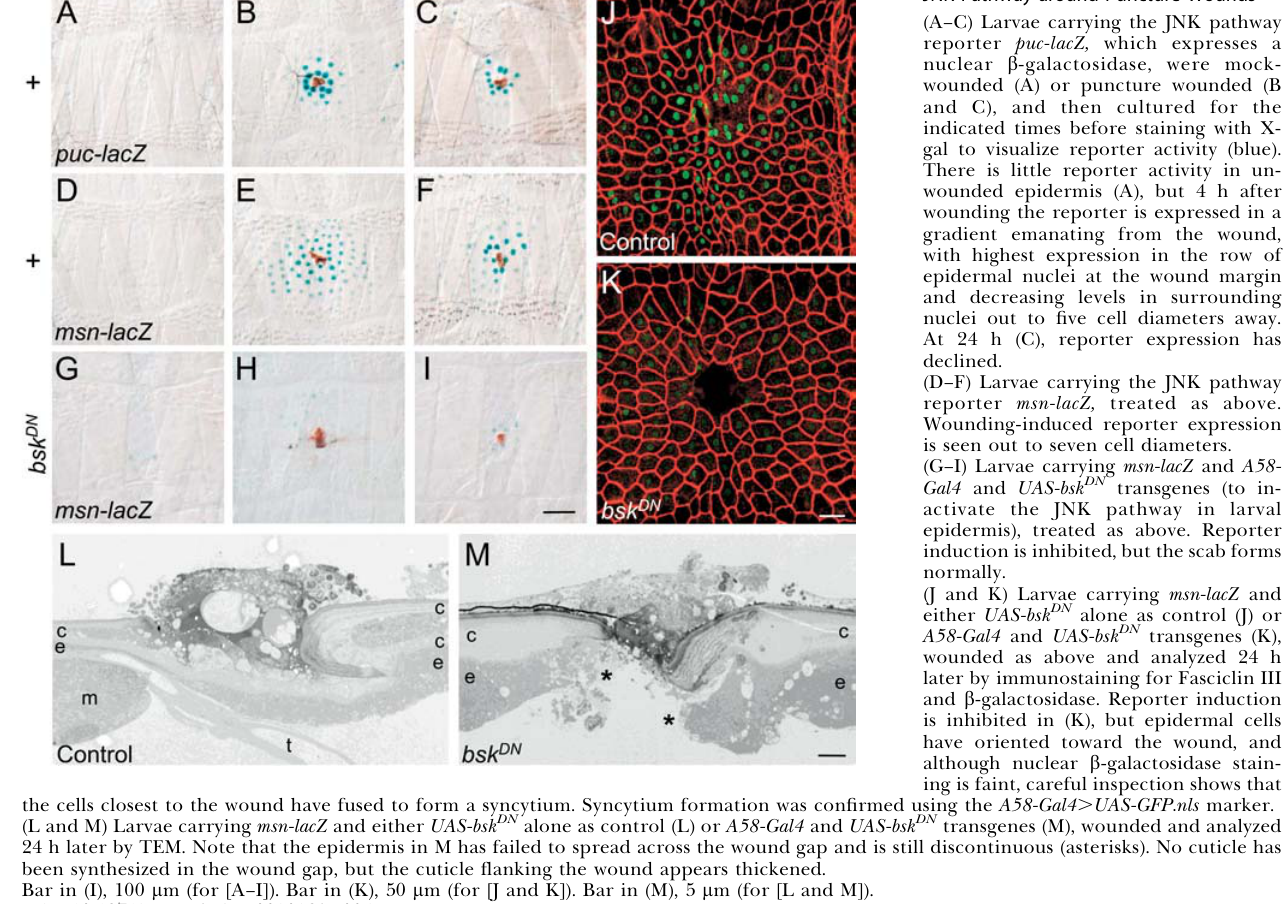
Figure 4. Induction and Function of the JNK Pathway around Puncture Wounds (A–C) Larvae carrying the JNK pathway reporter puc-lacZ, which expresses a nuclear b -galactosidase, were mock- wounded (A) or puncture wounded (B and C), and then cultured for the indicated times before staining with X- gal to visualize reporter activity (blue). There is little reporter activity in un- wounded epidermis (A), but 4 h after wounding the reporter is expressed in a gradient emanating from the wound, with highest expression in the row of epidermal nuclei at the wound margin and decreasing levels in surrounding nuclei out to five cell diameters away. At 24 h (C), reporter expression has declined. (D–F) Larvae carrying the JNK pathway reporter msn-lacZ, treated as above. Wounding-induced reporter expression is seen out to seven cell